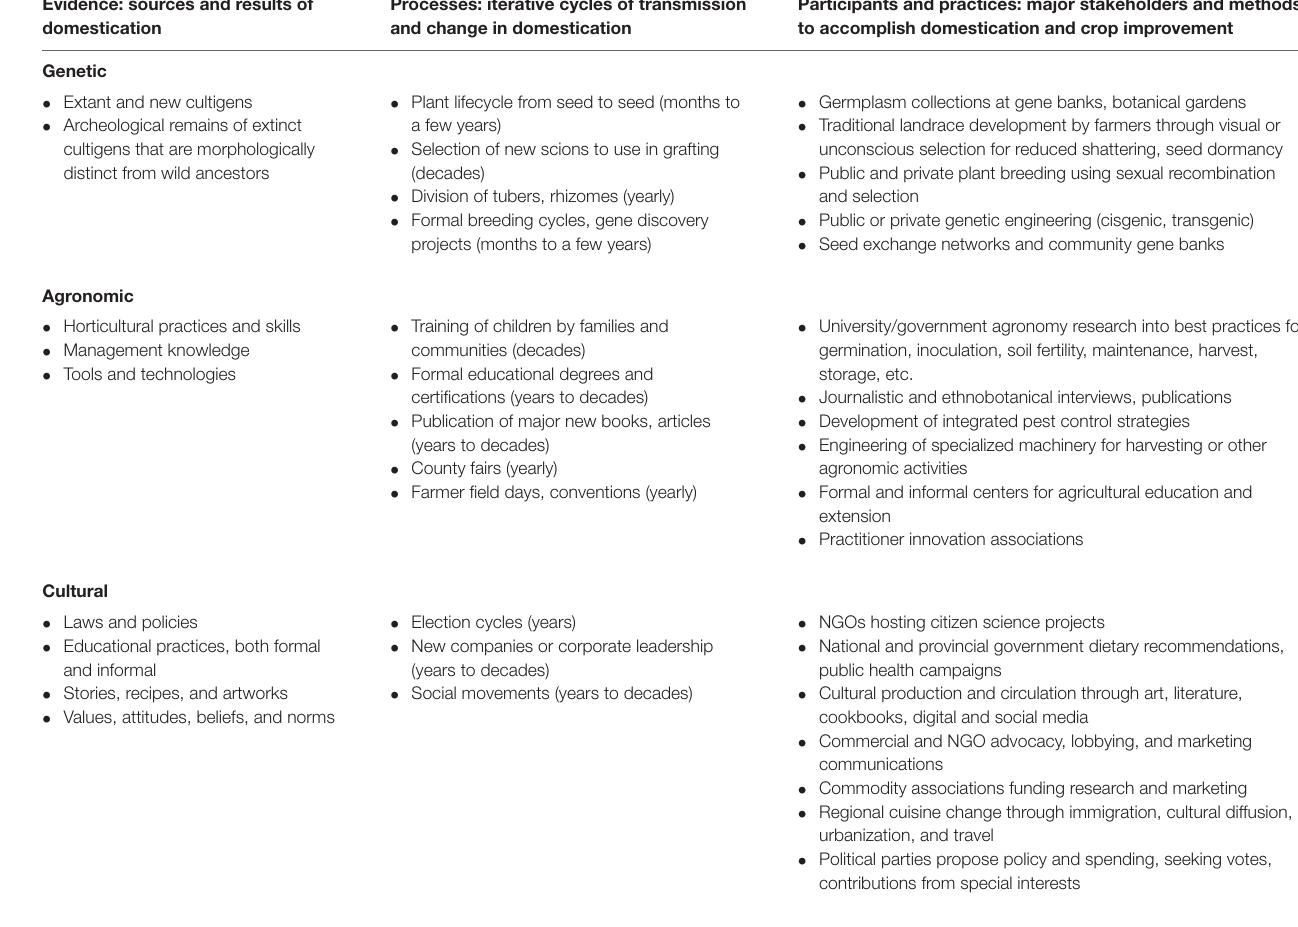
TABLE 1 | Common evidence, processes, and participants and practices involved in the genetic, agronomic, and cultural drivers of de novo domestication and crop